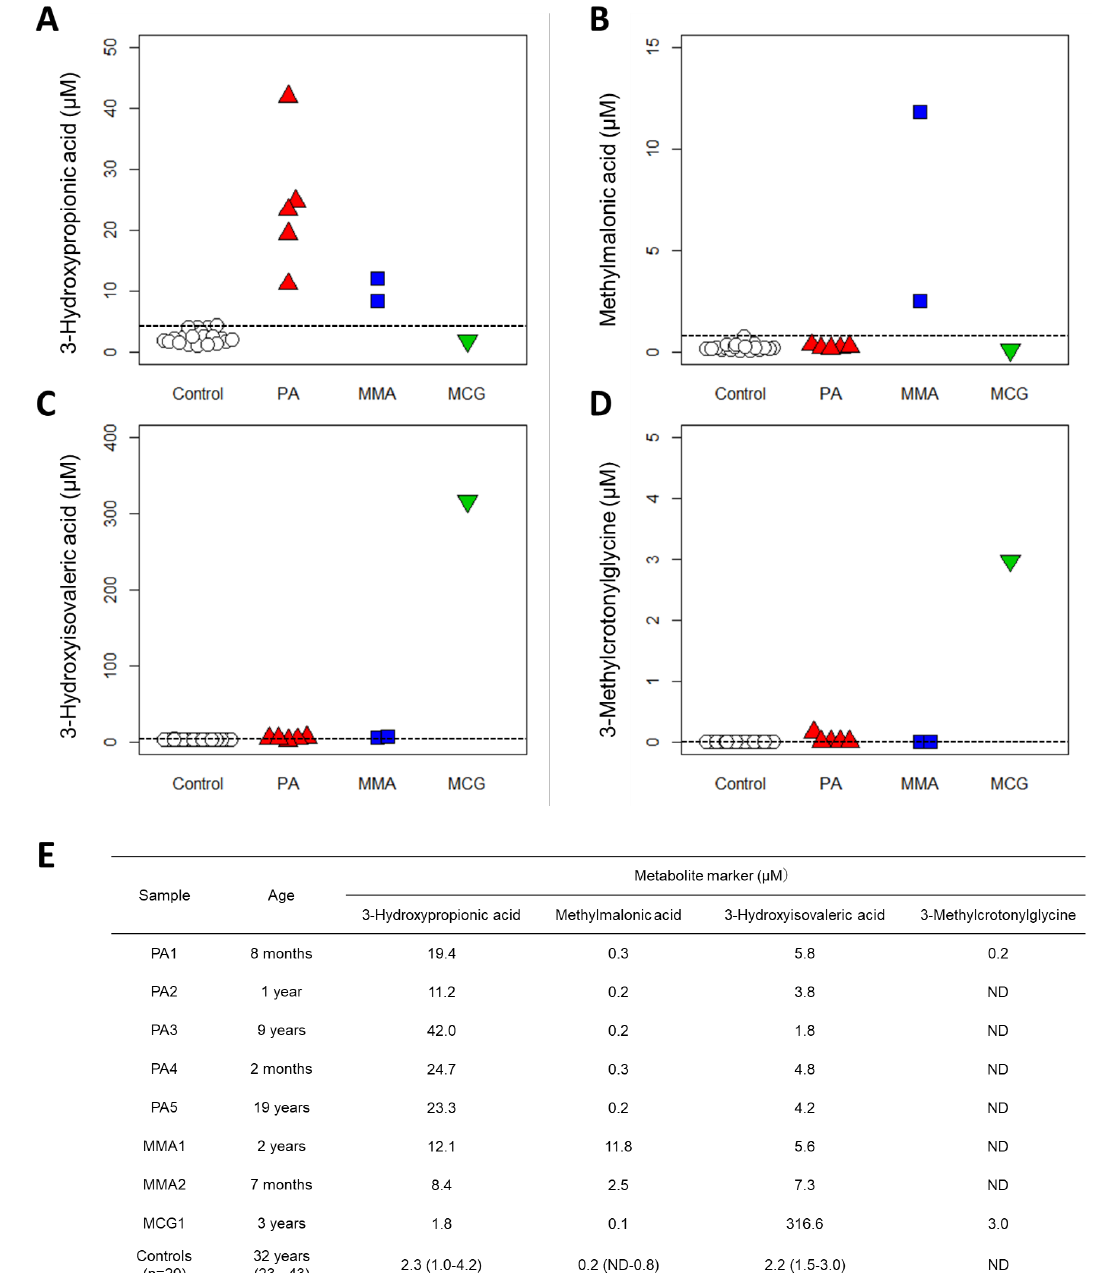
Figure 4. Results of clinical validation. Quantification results with new method from 20 controls and 8 patients: ( A ) 3-Hydroxypropionic acid, ( B ) Methylmalonic acid, ( C ) 3-Hydroxyisovaleric acid and ( D ) 3-Methylcrotonylglycine. PA: propionic acidemia. MMA: methylmalonic acidemia. MCG: methylcrotonylglycinuria. Dashed lines indicate the maximum value of controls. ( E ) Patient data and control data (medians (ranges)). ND: not detected, plotted as 0 µM.